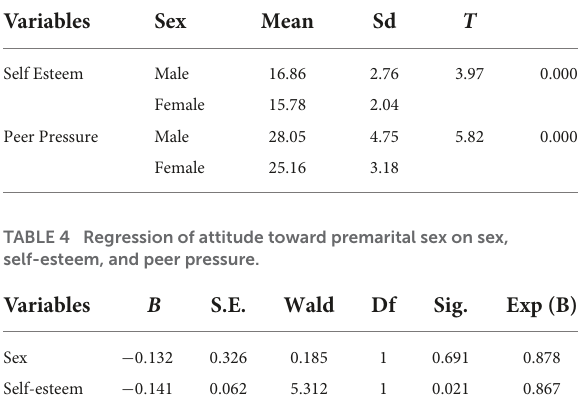
TABLE 3 Sex differences in the level of self-esteem and exposure to peer pressure among students having the experience of premarital sex.